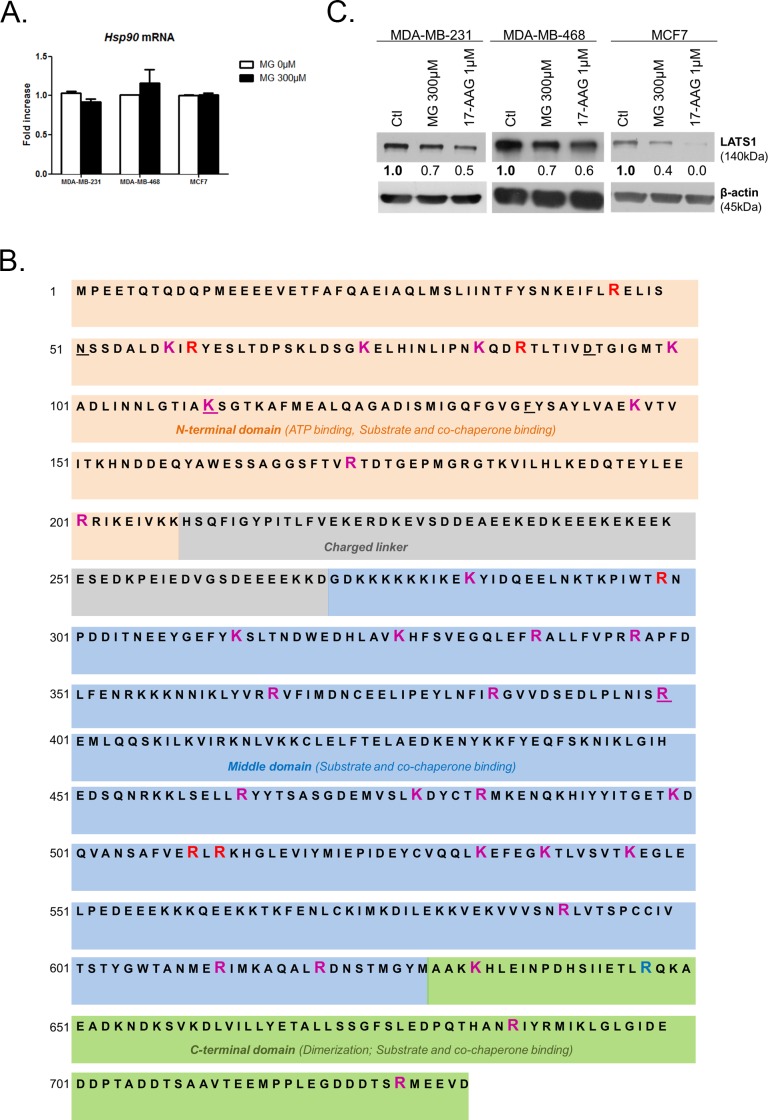
MG induces Hsp90 post-translational glycation.(A) MG treatment from low to high density did not affect HSP90 mRNA levels as assessed by qRT-PCR in the indicated cell lines. Data were analyzed using unpaired student’s t test and shown as the mean values ± SEM of three independent experiments. (B) MG-modifications represented on Hsp90α amino acid sequence. Underlined amino acids represent ATP binding site. Magenta and blue amino acids represent MG-modifications observed on recombinant and endogenous Hsp90, respectively. Red amino acids represent MG-modifications found in both conditions. (C) LATS1 expression is decreased in breast cancer cells treated with MG (300 µM) or 17-AAG (1 µM) during 24 hr. Immunoblot data were quantified by densitometric analysis and normalized for β-actin. Numbers represent fold increase relative to the condition shown with bold number. Western blot are representative of three independent experiments.